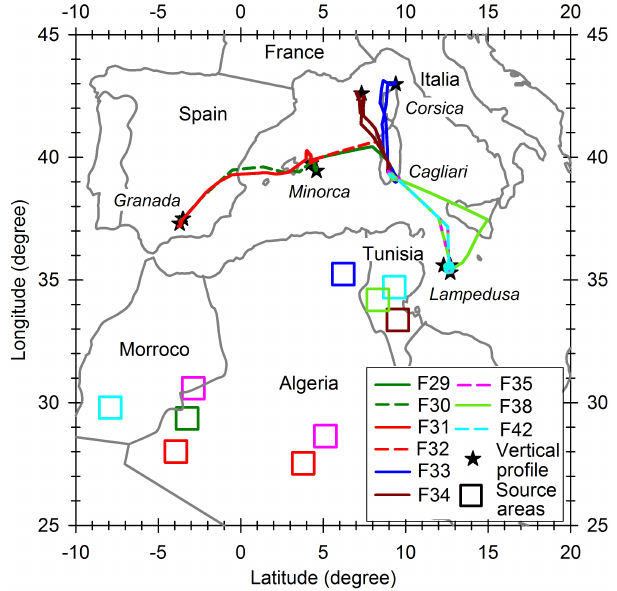
Figure 1. Operating region of the ATR-42 aircraft during the ADRIMED flights that performed mineral dust measurements. Colours of the lines and squares correspond to the different flights. The positions of the middle of the profiles are shown in black stars. Squares indicate likely sources regions of the dust sampled during the flights (see Sect. 3.1 for identification methodology). The air- craft was based at Cagliari in